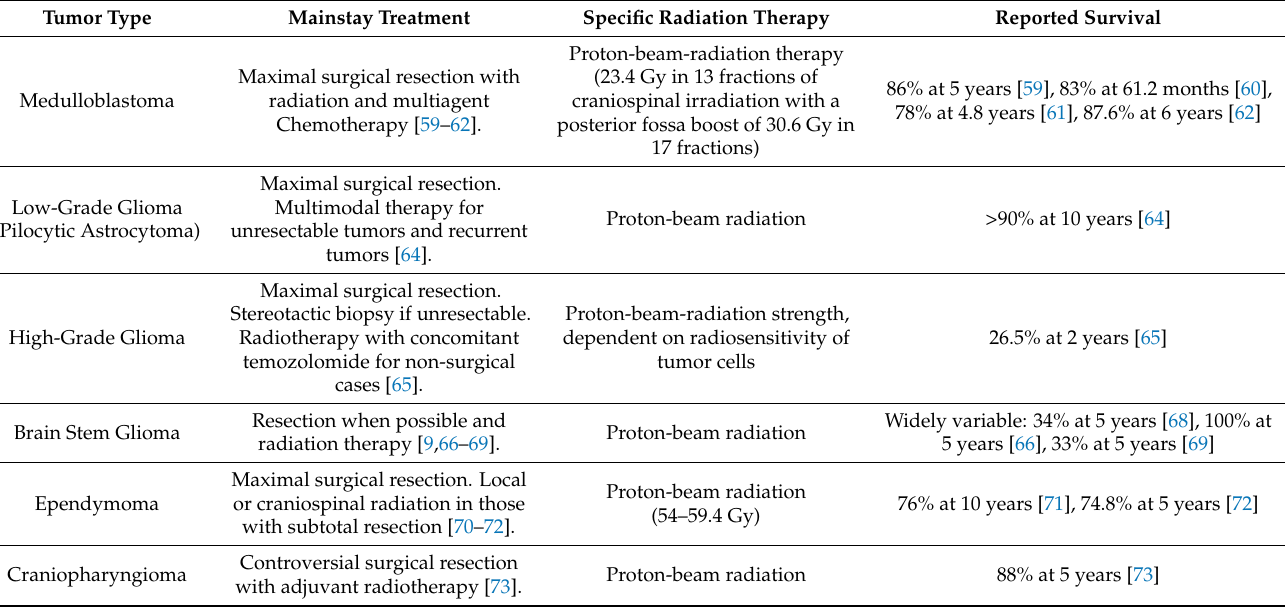
Table 1. Description of pediatric-tumor treatments including proposed management and